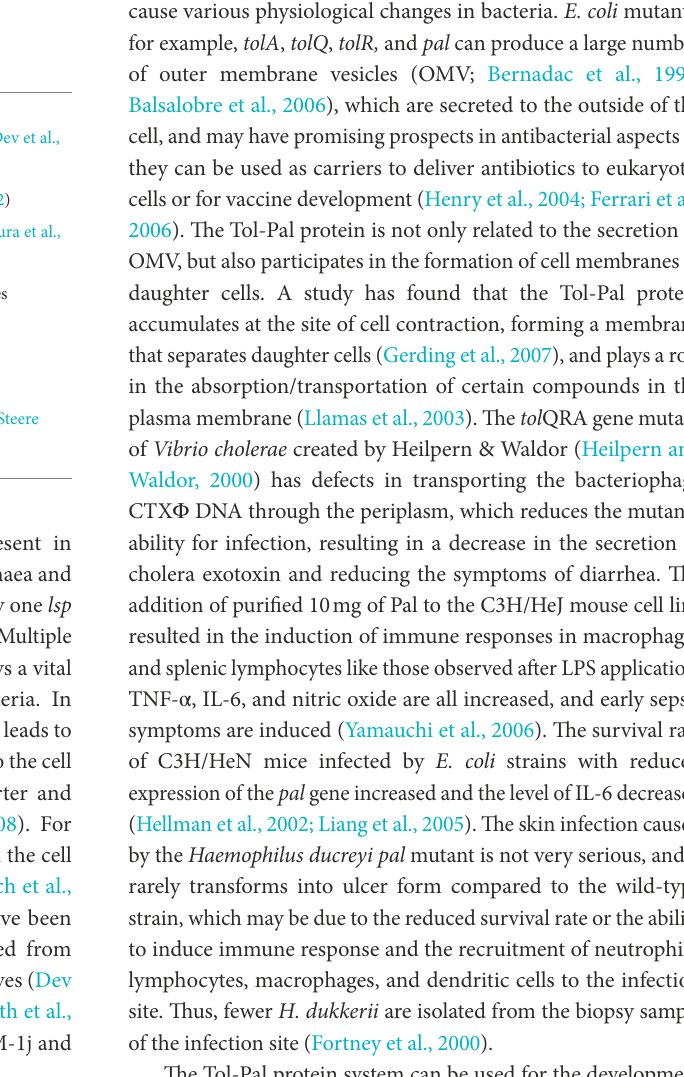
TABLE 1 Potential inhibitors target